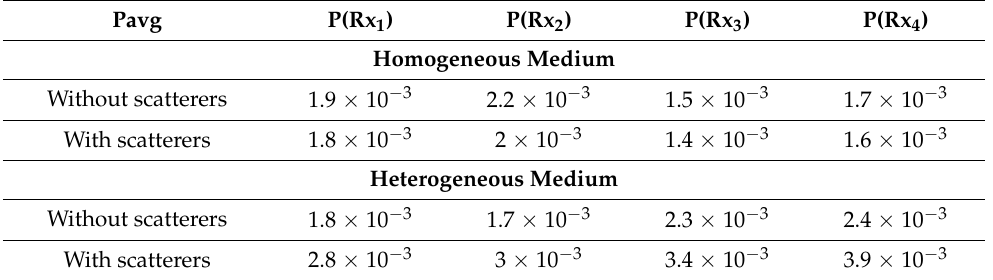
Table 3. Average received power in watts.